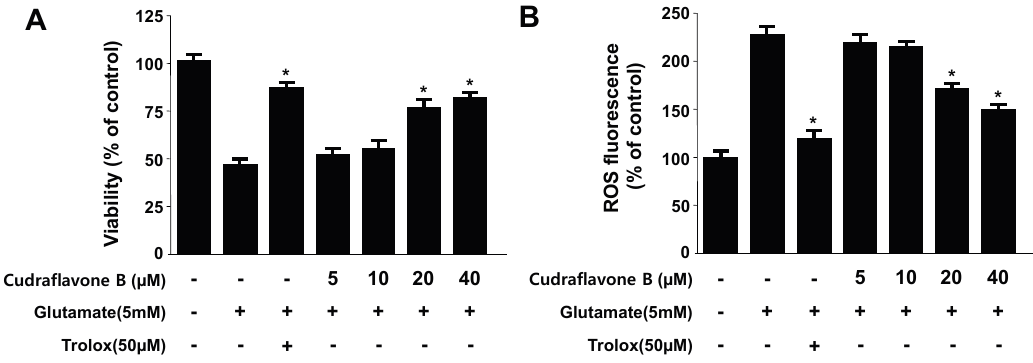
Figure 2. Effects of cudraflavone B on glutamate-induced oxidative neurotoxicity ( A ) and ROS generation ( B ) in HT22 cells. HT22 cells were pre-treated with cudraflavone B for 12 h and then incubated for 12 h with glutamate (5 mM). Exposure of HT22 cells to glutamate increased ROS production. Data are presented as mean ± SD values of three independent experiments. Trolox (50 μ M) was used as the positive control. * p < 0.05 vs. glutamate.